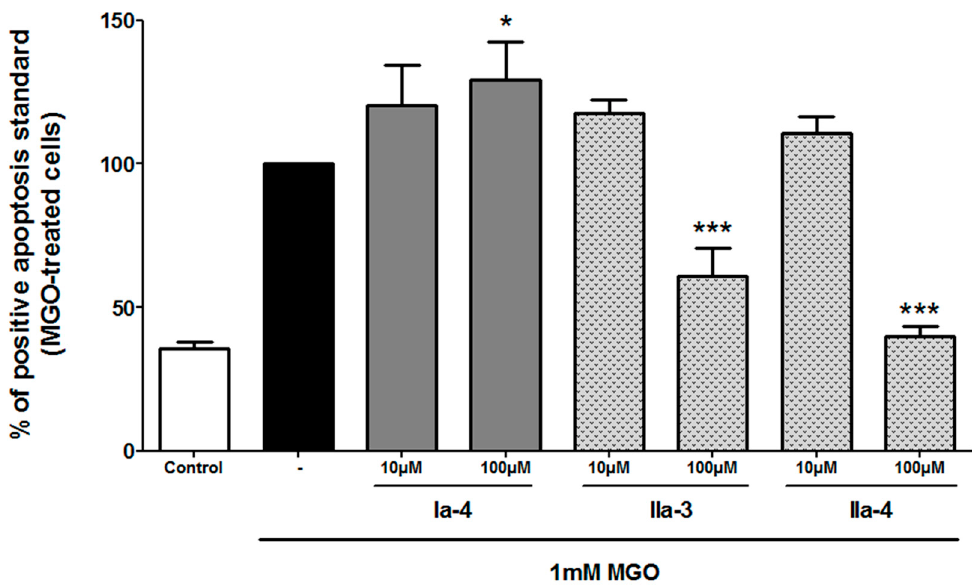
Figure 7. In vitro evaluation of MGO-induced apoptosis inhibition in neuronal-like PC12 cells. PC12 cells were incubated for 24 h in media (control), and with MGO (1 mM) in the absence or the presence of either 10 µ M or 100 µ M of key AGE / ALE inhibitors Ia-4, IIa-3 and IIa-4. At the end of the incubation, the cells were lysed and analyzed for DNA fragmentation. Bars represent the means ± SEM of at least three independent experiments performed in triplicate. * p < 0.05; *** p < 0.001 vs. control (Student’s t test: p values < 0.05 were considered significant).